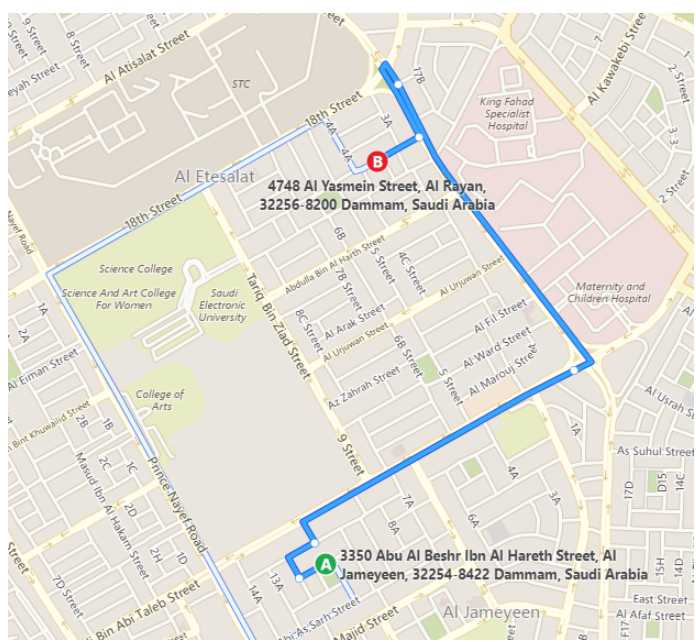
Figure 1. The shortest path between A and B in a spatial road network.